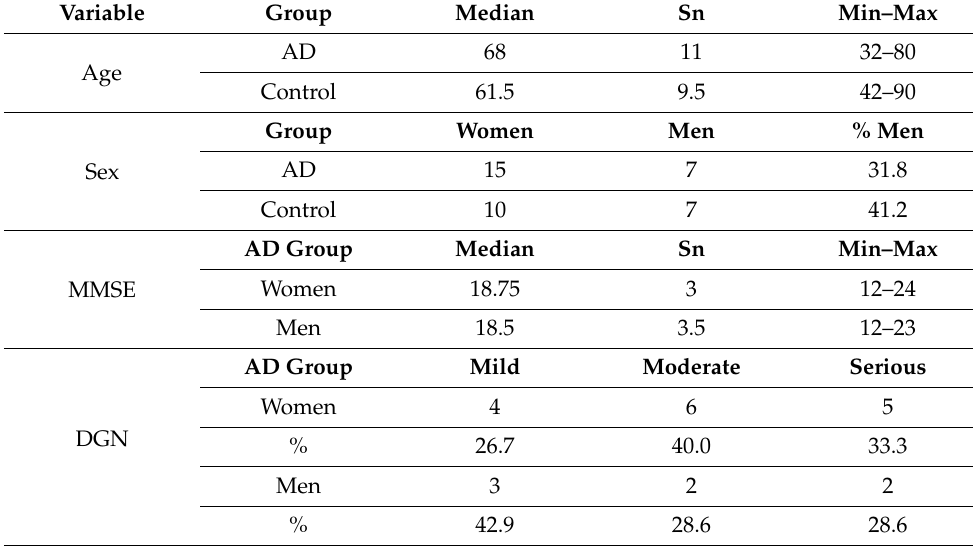
Table 2. Characteristics of blood donors—AD patients and